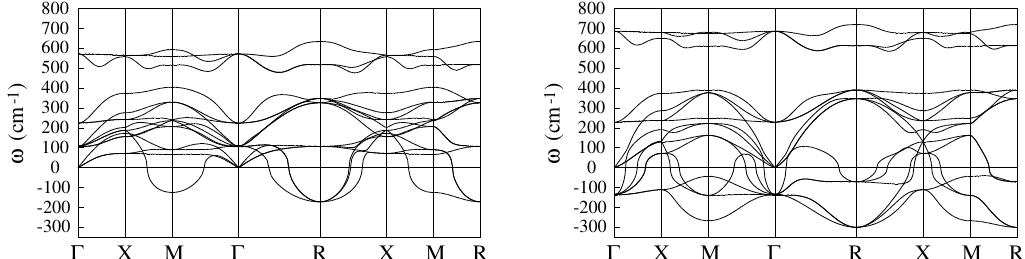
Figure 1: Calculated PBE GGA non-spin-polarized phonon dispersions of cubic LaNiO (left) and cubic YNiO (right). The imaginary frequencies are denoted by 3 3 negative